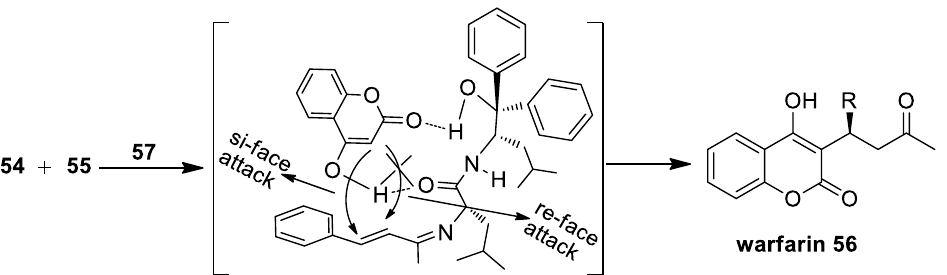
19 of 36 Scheme 22. Asymmetric synthesis of warfarin using amino amides as chiral templates. OR 3 R